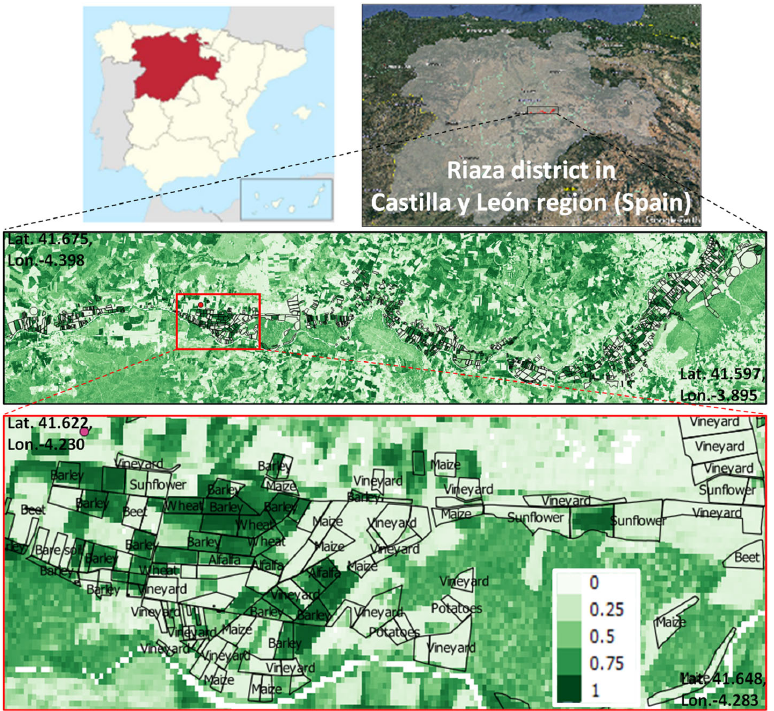
Figure 1. Top panel : Castilla y Le ó n region in Spain and the Riaza irrigation district location. Middle panel : zoomed-in view of the black rectangle with parcel borders overlayered on the S-2 NDVI on 30 April 2019. Red point indicates the VA07 Inforiego meteorological station. Bottom panel : zoomed ‐ in view of the red rectangle with crop type information. Geographic coordinates of the corners are reported.